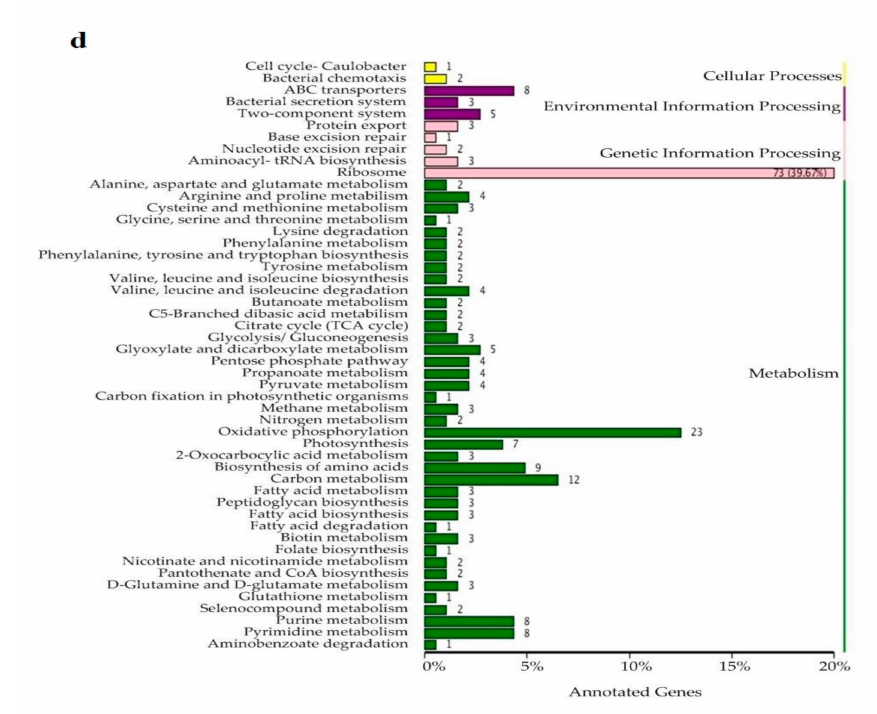
Figure 4. Kyoto Encyclopedia of Genes and Genomes (KEGG)classification map of DEGs. The Y -axis indicates the name of metabolic pathway. The X -axis indicates the number of genes annotated to the pathway and its proportion to the total number of genes annotated. ( a ) DEGs between CK and NPK; ( b ) DEGs between CK and NPK + S0.5; ( c ) DEGs between CK and S0.5; ( d ) DEGs between NPK and